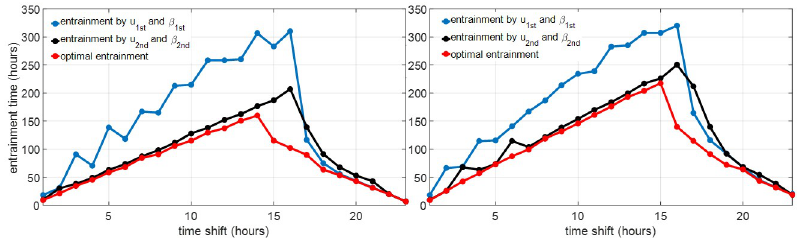
Fig 10. Entrainment time by applying the optimal light and sleep schedule of the simplified models on the full model with I max = 10000 lux (left) and I max = 1000 lux